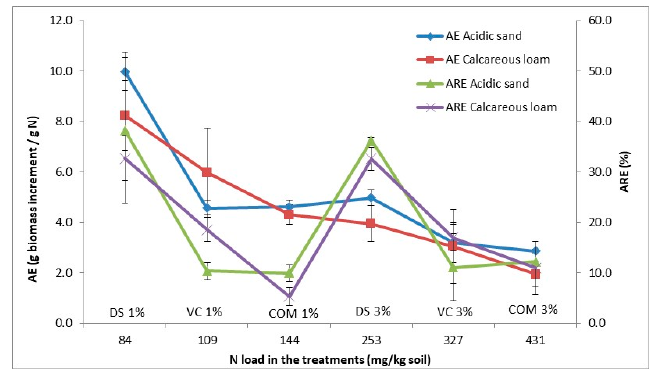
Figure 6. Agronomic efficiency (AE) and apparent nitrogen recovery efficiency (ARE) as a function of the nitrogen loads in the digested sludge (DS), digested sludge compost (COM), and digested sludge vermicompost (VC) treatments. Error bars represent the standard deviation (SD) of the mean with 3